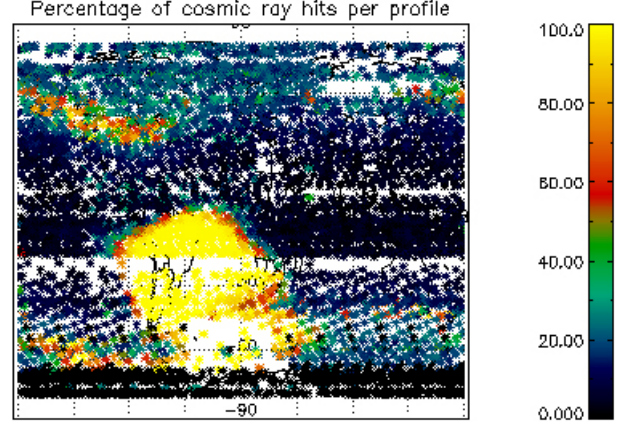
Fig. 20. Each point of the world map is the position of ENVISAT at the time of one occultation recorded by GOMOS during the month of November 2004. The color coding describes the percentage of 0.5s samples of CCD spectrometers that have at least one cosmic hit. Both North and South auroral zones are visible, but the region most affected is the South Atlantic